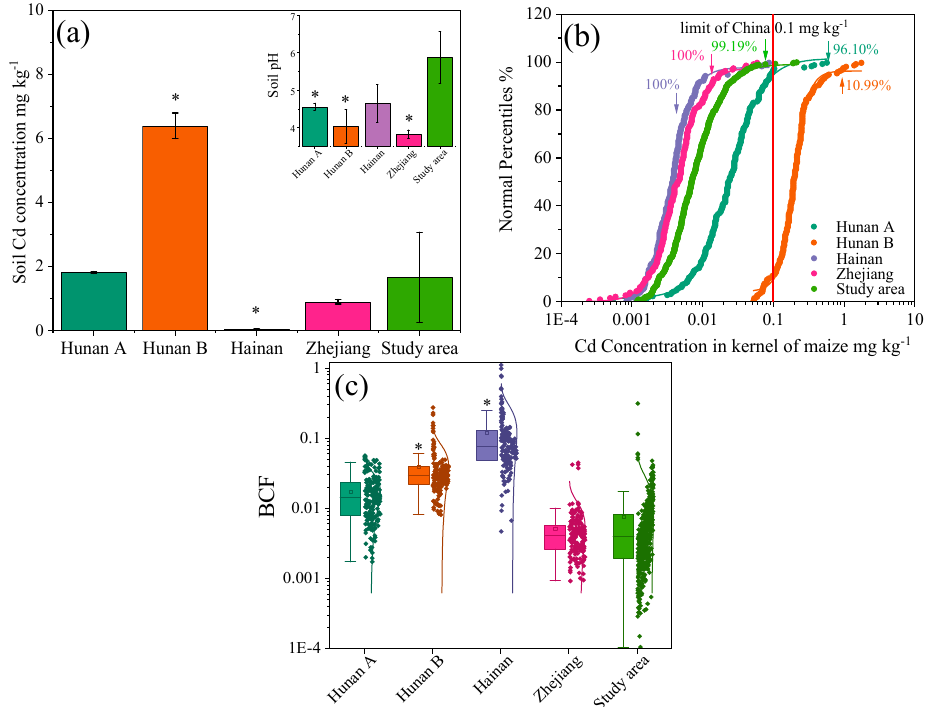
Figure 4. Soil Cd concentration and soil pH value ( a ), Cd concentration of kernels in the form of a cumulative distribution function ( b ), bioaccumulation factor of Cd ( c ) in the study area and a maize field in Hunan, Zhejiang, and Hainan Provinces, China. * indicates a significant difference between the data in the reference area and the data in the study area (Duncan’s test) ( p < 0.05).